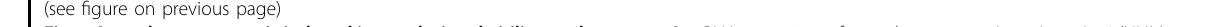
Fig. 1 Autophagy process is induced in non-lesional vitiligo melanocytes. A mRNA transcripts of autophagy genes Atg5, Atg7, Atg8 (NHMs n = 7 and VHMs n = 7); B Western blot with average value of densitometric analysis of LC3-II/I expression on vitiligo lysates normalized on control ones. A representative blot is shown (NHMs n = 4 and VHMs n = 4); C Immuno fl uorescence analysis of LC3 (red) and corresponding quantitative analysis of the number of LC3 positive puncta per cell. Nuclei were counterstained with DAPI. Red boxes show the enlarged view of the selected dashed areas. The arrows point at LC3 positive dots. Quanti fi cation of positive puncta per cell is expressed as fold change relative to NHMs value, which was set as 1 by de fi nition ( n = at least 150 cells per group). Scale bars 10 μ m; D , E Western blot of SQSTM1/p62 and Beclin I expression and corresponding densitometric analyses on vitiligo lysates normalized on control ones (NHM n = 4; VHM n = 4); F TEM representative images of normal human melanocytes (NHMs) and G non-lesional vitiligo melanocytes (VHMs). Black arrows in F point at different stages of melanosomes (see magni fi cation). Black arrows in G indicate degradative autophagic vacuoles containing melanin or melanosomes (see magni fi cation) (NHM n = 3; VHM n = 3); TEM micrographs, uranyl acetate/lead citrate; Nu, Nucleus; NM, nuclear membrane; PM, plasma membrane; Mi, Mitochondrion. Atg5 , autophagy related 5; Atg7 , autophagy related 7; Atg8 , autophagy related 8; LC3, (microtubule-associated protein 1) light chain 3; NHMs, normal human melanocytes; SQSTM1/p62, sequestosome-1; VHMs, vitiligo human